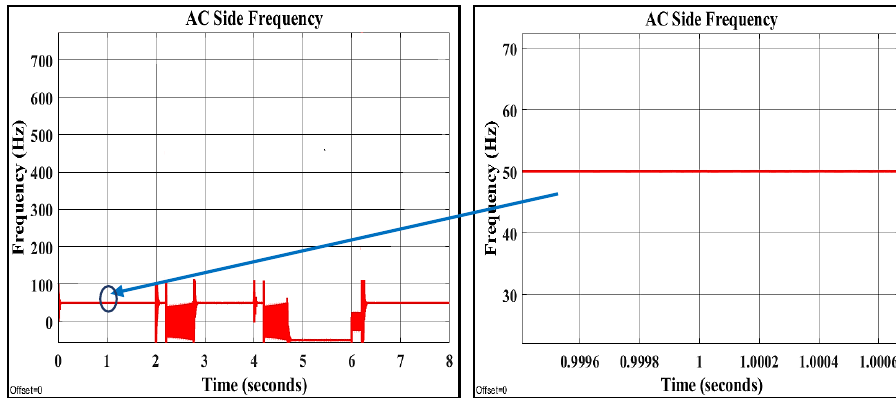
Figure 20. Three-phase AC bus current and voltage under fault conditions .